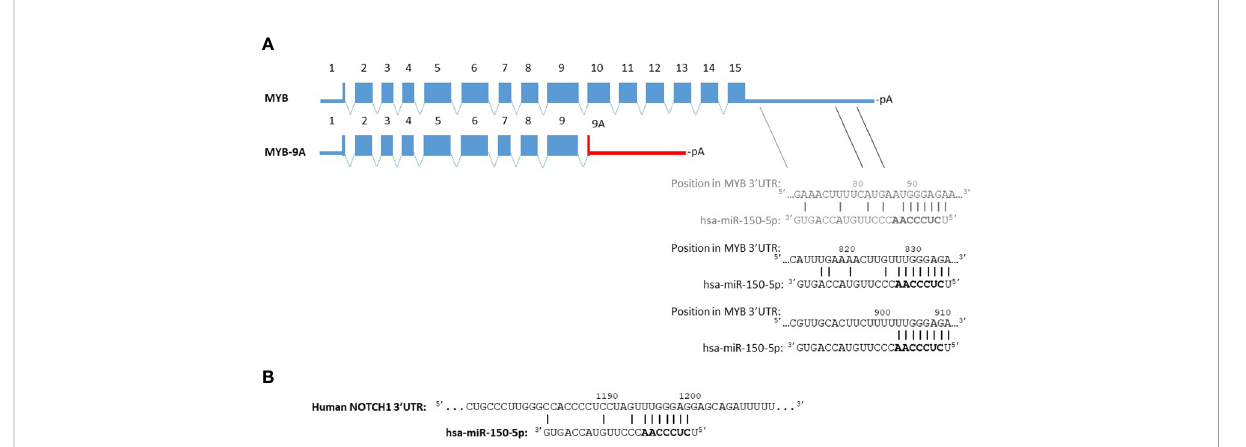
FIGURE 1 miR-150 binding site predictions for MYB-9A and NOTCH1. Panel (A) The alternatively spliced transcript coding for full-length MYB (640 amino acids) contains 15 exons. TargetScan (46) predicts 3 binding sites for miR-150 in the MYB 3 ’ UTR (ENST00000367814.4, 1193 nt). The second and third sites were found to be functionally relevant by Xiao et al. (38). The 3 ’ UTR of MYB-9A (402 amino acids) has not been experimentally veri fi ed. The red line indicates a predicted 3 ’ UTR based on the presence of a consensus sequence for polyadenylation (47) downstream of the MYB-9A stop codon. The miRNA target prediction tools STarMir (48) and RNA22 (49) do not identify miR-150-5p binding sites in this sequence. Panel (B) An NCBI BLAST search of the region spanning the functionally relevant miR-150 binding site in the murine NOTCH1 3 ’ UTR characterized by Deng et al. (50) identi fi ed a highly similar sequence in the human NOTCH1 3 ’ UTR. This segment contains a potential binding site for miR-150-5p according to TargetScan analysis of the NOTCH1 3 ’ UTR (ENST00000277541.6, 1627 nt). TargetScan Release 8.0: https:// www.targetscan.org/vert_80/, STarMir: http://sfold.wadsworth.org/, RNA22 version 2.0: